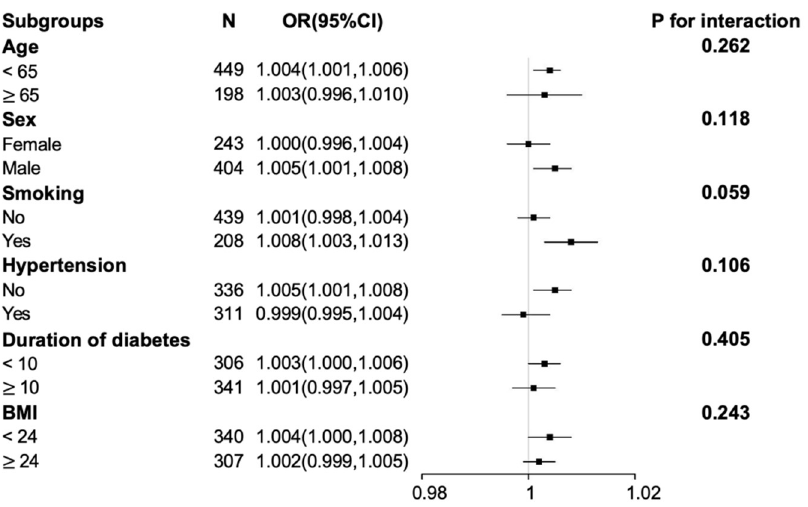
Figure 2. Odds ratios (ORs) for associations between serum uric acid and the risk of diabetic peripheral neuropathy (DPN) in subgroup analyses. The above model (model 2) adjusted for gender, age, duration of diabetes, glycated hemoglobin (HbA1c), body mass index, smoking, hypertension, total cholesterol, triglyceride, high-density lipoprotein cholesterol, low-density lipoprotein cholesterol, and free thyroxine (FT4). In each subgroup, the model is not adjusted for the stratification variable. Abbreviations: CI, confidence interval.